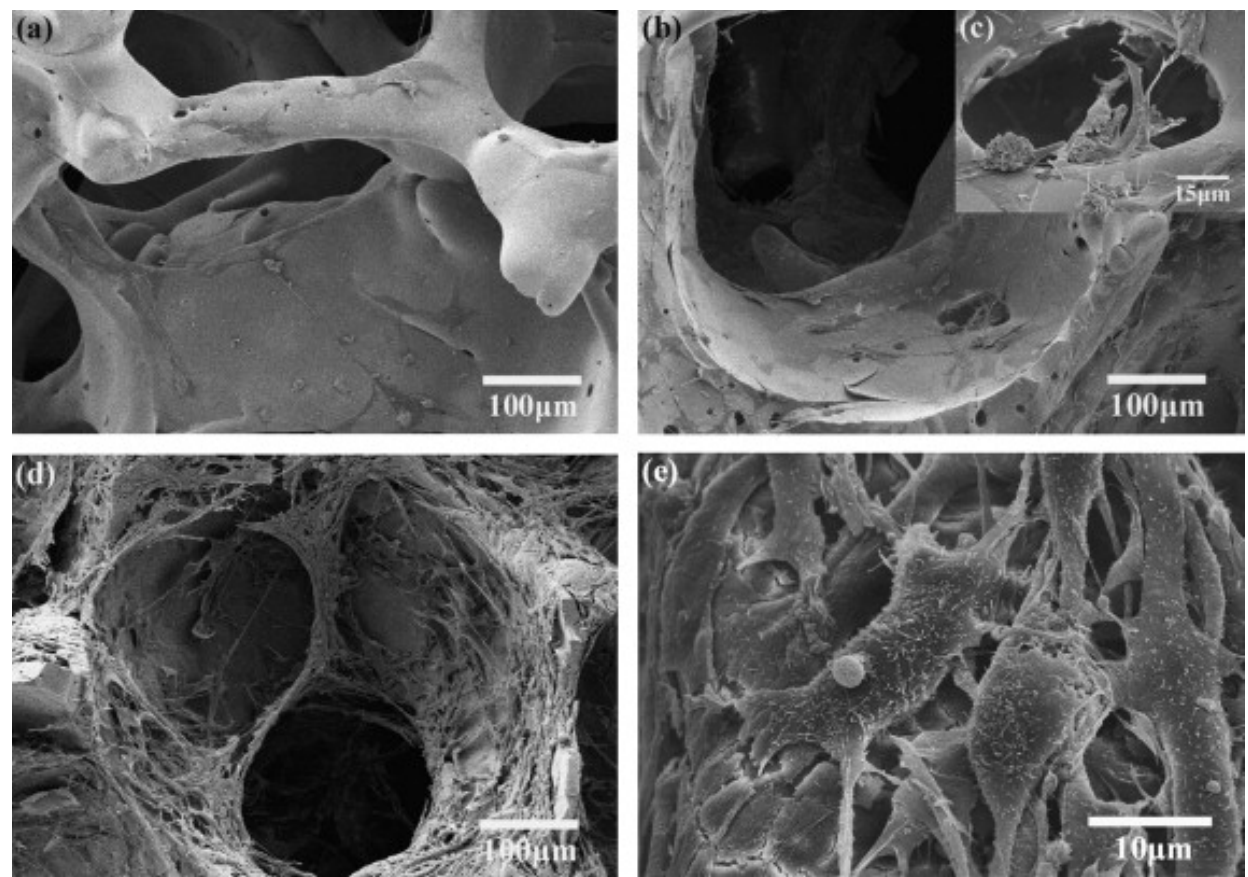
Figure 4. SEM images of 13–93 glass scaffolds seeded with MC3T3-E1 cells and cultured for: (a) 2 days; (b, c) 4 days; and (d, e) 6 days [105]. Reprinted with permission of